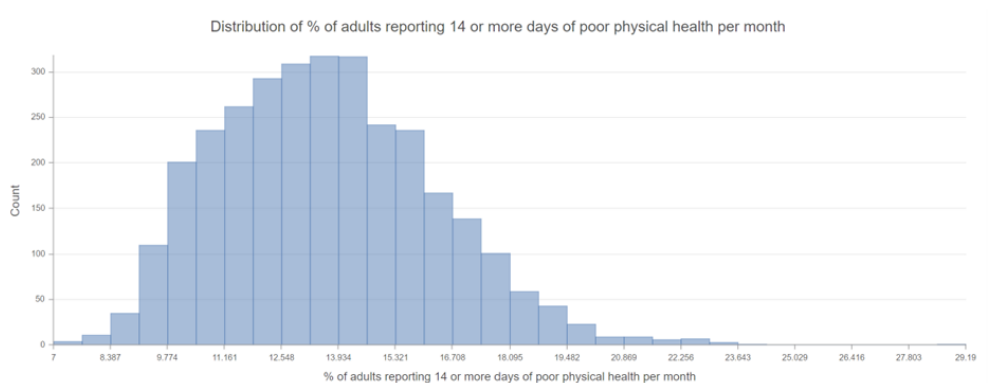
Figure 5. Distribution of Poor Physical Health